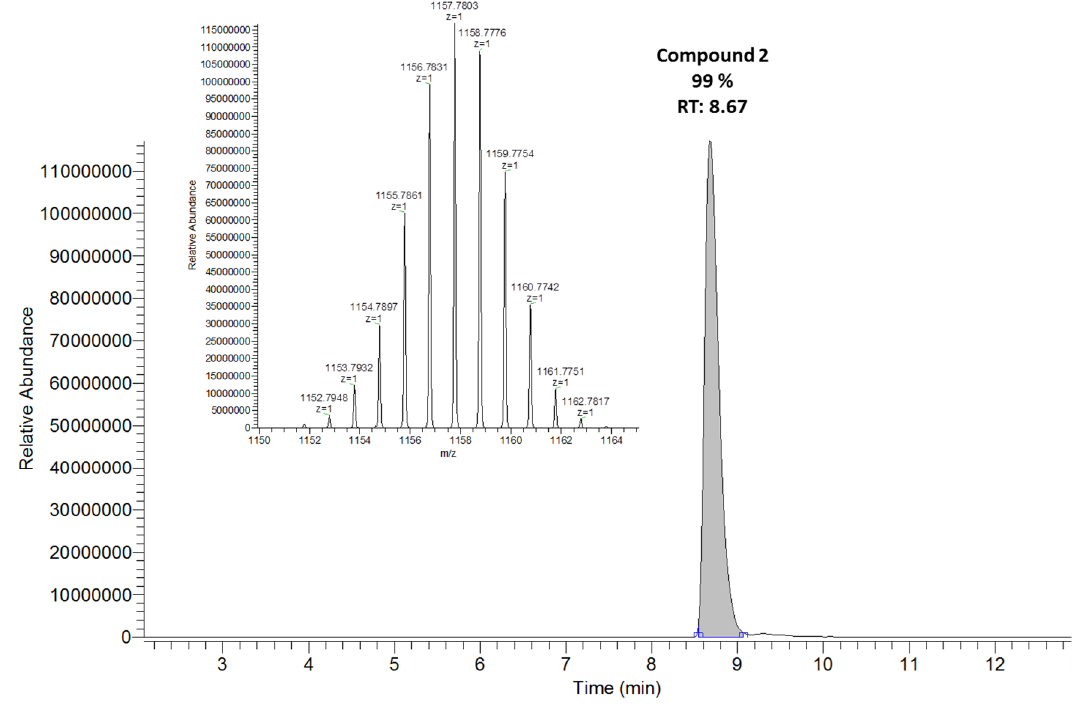
Figure 1. Total ion chromatogram of collected fraction by purifying reaction mixture by ÄKTA Pure 25. Percentage of compound 2 = 99%, RT = 8.67 min, m / z [M + H] + = 1,157.7794.